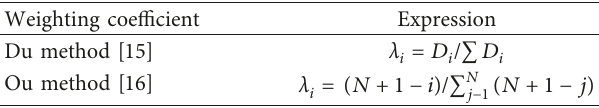
Table 2: Weighting coefficient method adopted in this study. Weighting coefficient